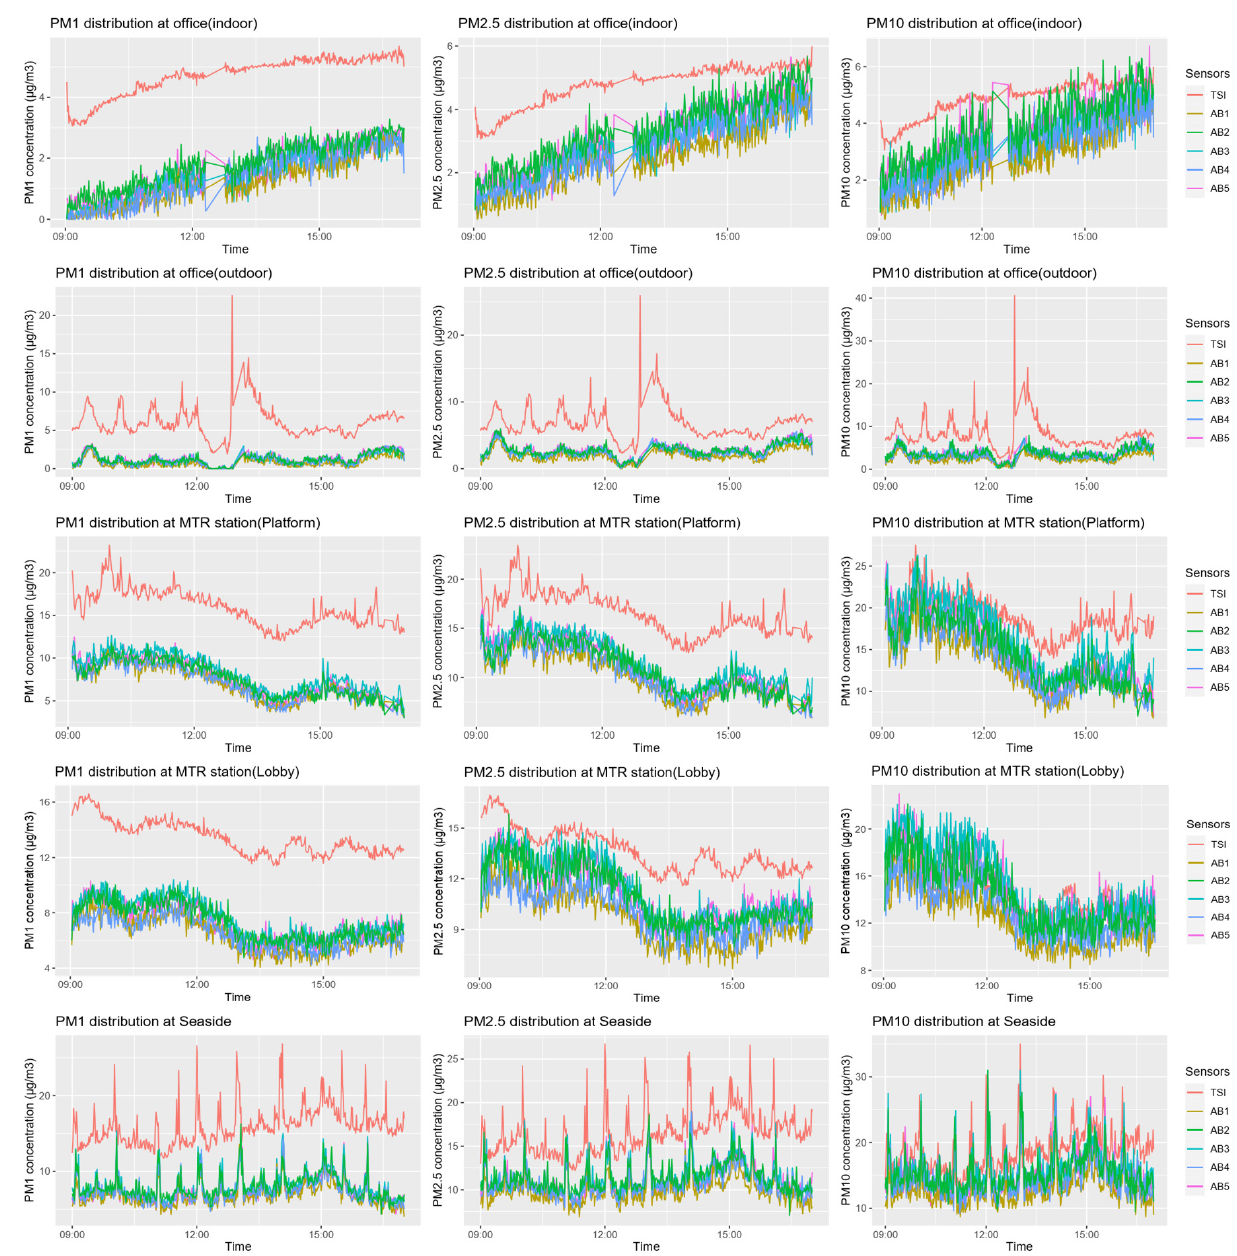
Figure 1. The 1 min PM1, PM2.5, and PM10 average concentrations ( µ g/m 3 ) reported by AirBeam2 and DustTrak sensors in different environments.